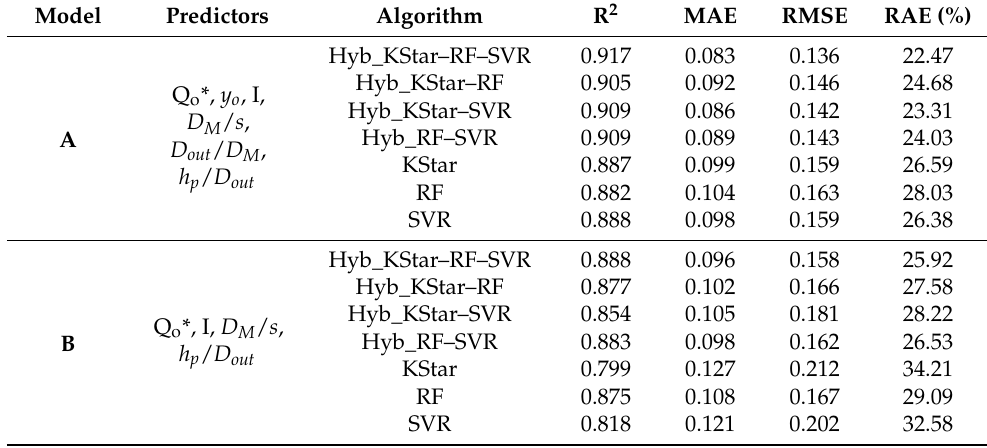
Table 3. Prediction models and variants, with the relevant predictors and evaluation metrics.